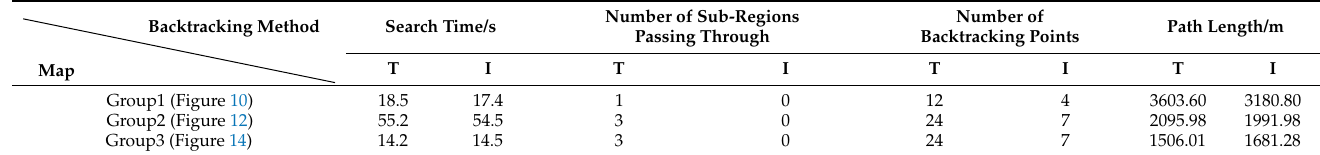
Table 11. Experimental